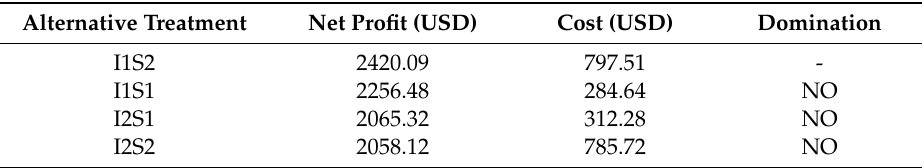
Table 9. Analysis of plan by the priority investment method.